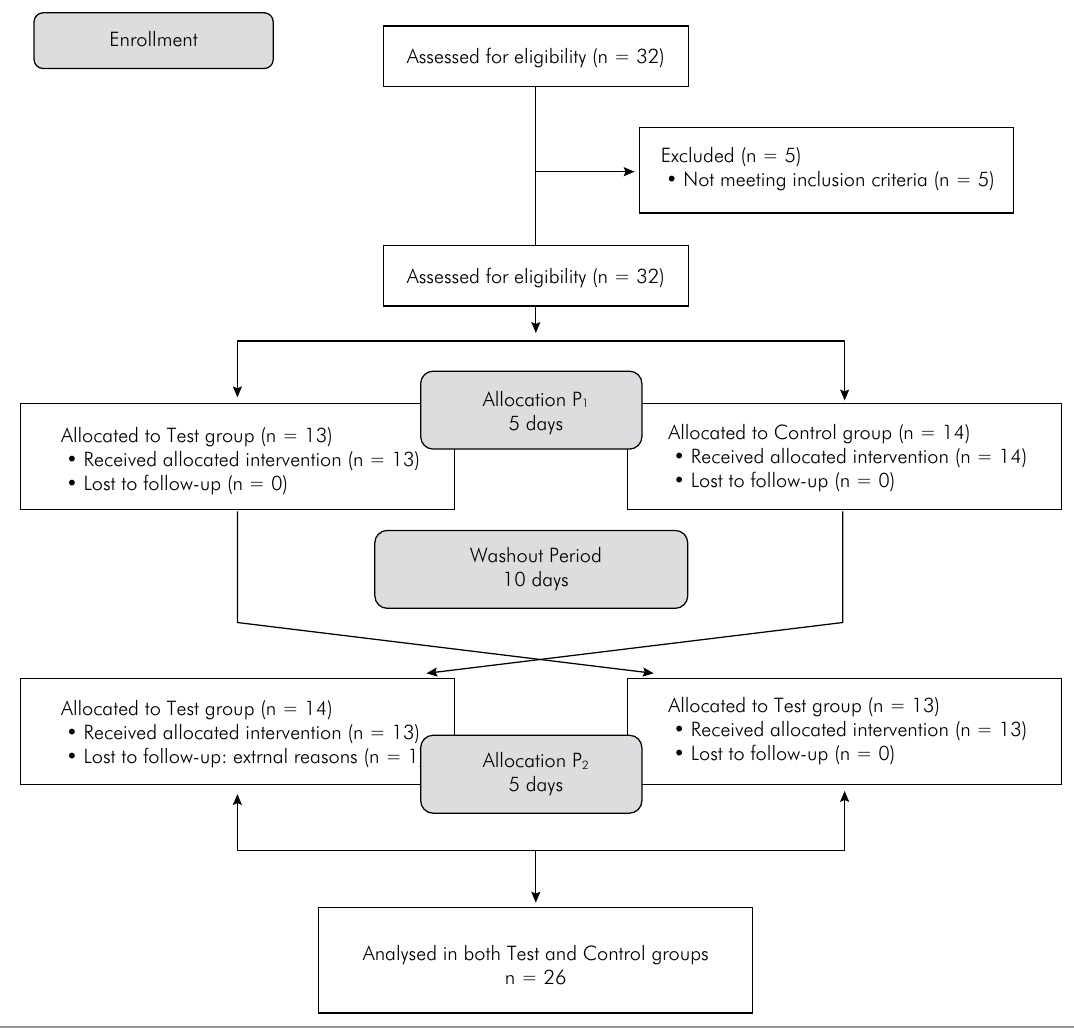
Figure 1. Flowchart of the